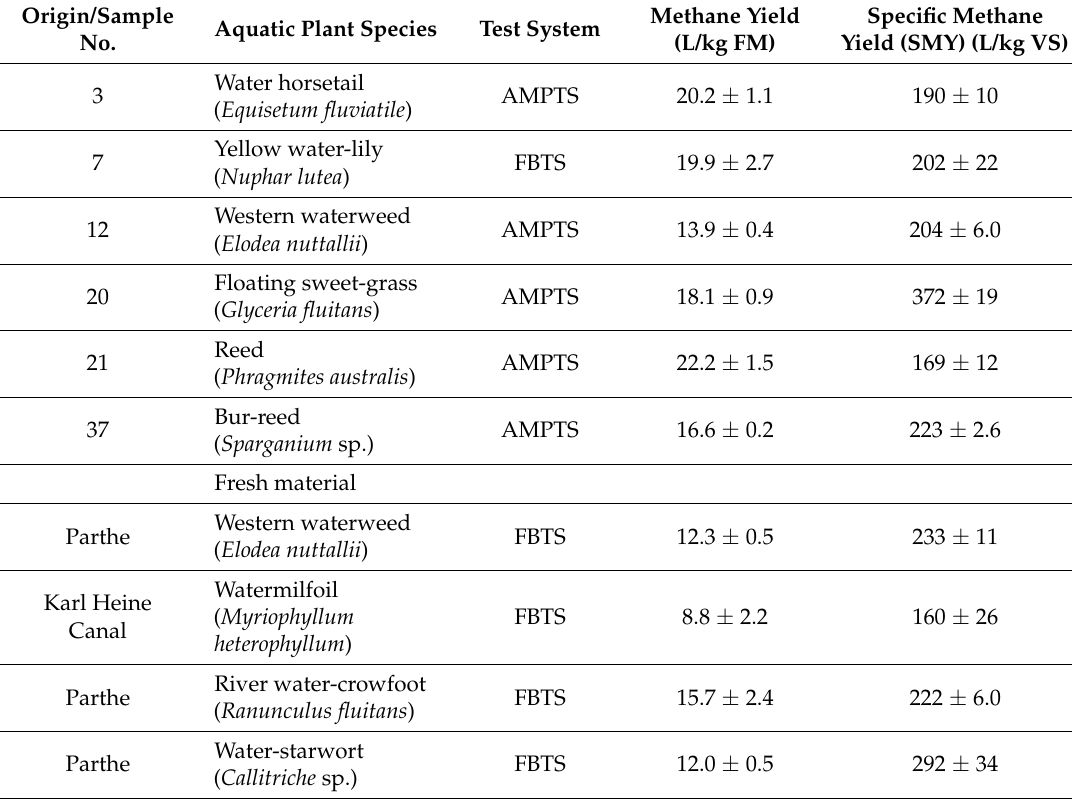
Table 8. Methane yields of selected aquatic